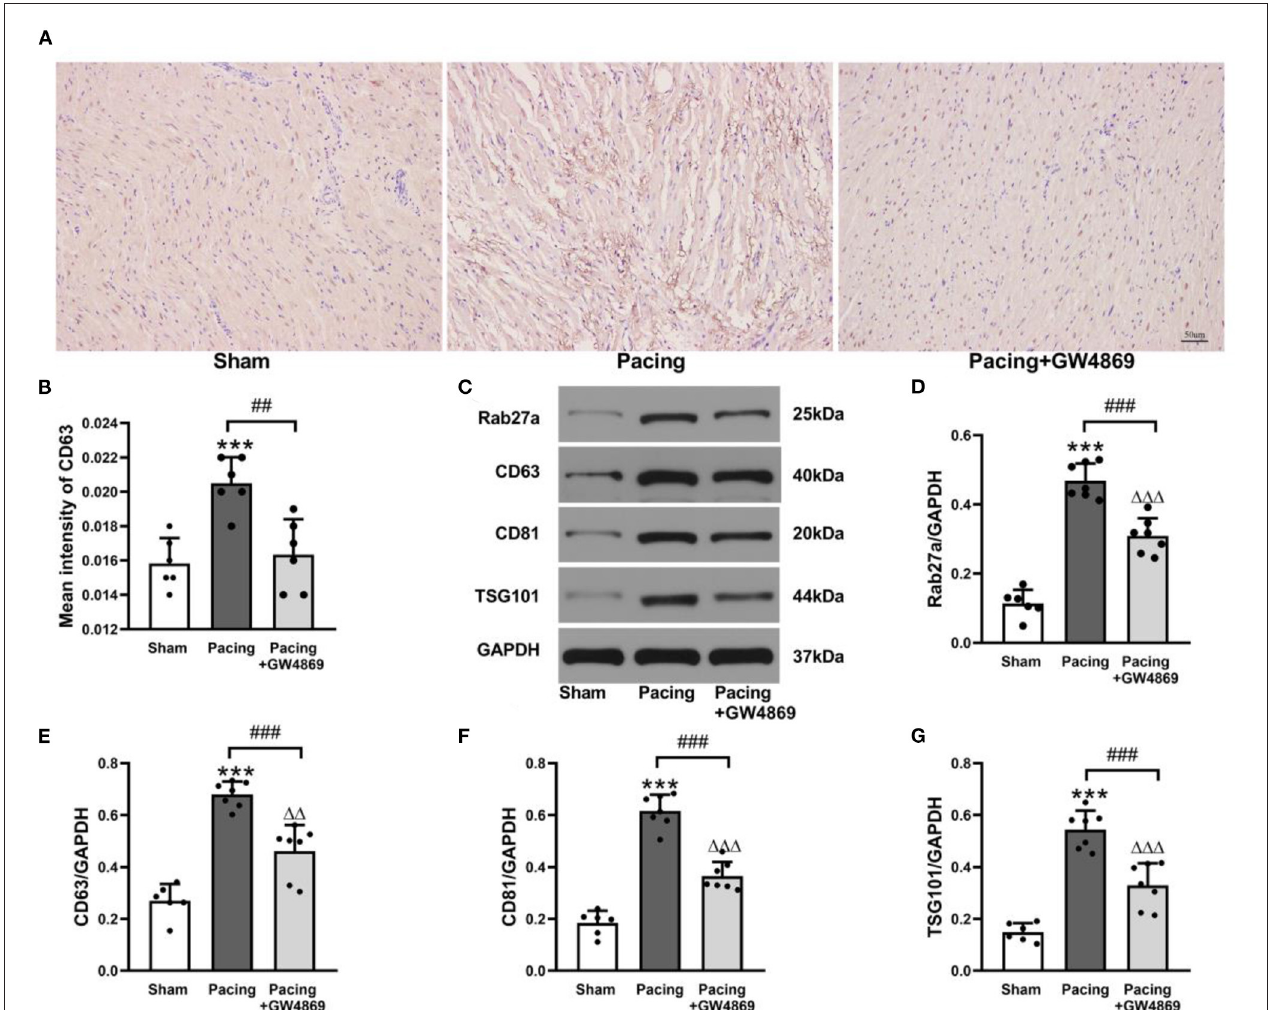
FIGURE 3 | Analysis of exosomal marker proteins in the atria from a canine AF model. (A,B) Immunohistochemistry staining of CD63 and mean values of CD63 intensity in the atria ( n = 6, × 200). (C) Representative western blotting images of Rab27a, CD63, CD81, and TSG101 in the atria ( n = 6 for the sham group and n = 7 for the pacing and GW4869 groups). (D–G) The mean expression levels of Rab27a, CD63, CD81, and TSG101 in the atria ( n = 6 for the sham group and n = 7 for the pacing and GW4869 groups). *** P < 0.001 vs. the sham group. ## P < 0.01 vs. the pacing group, ### P < 0.001 vs. the pacing group. 11 P < 0.01, 111 P < 0.001 vs. the sham group. AF, atrial